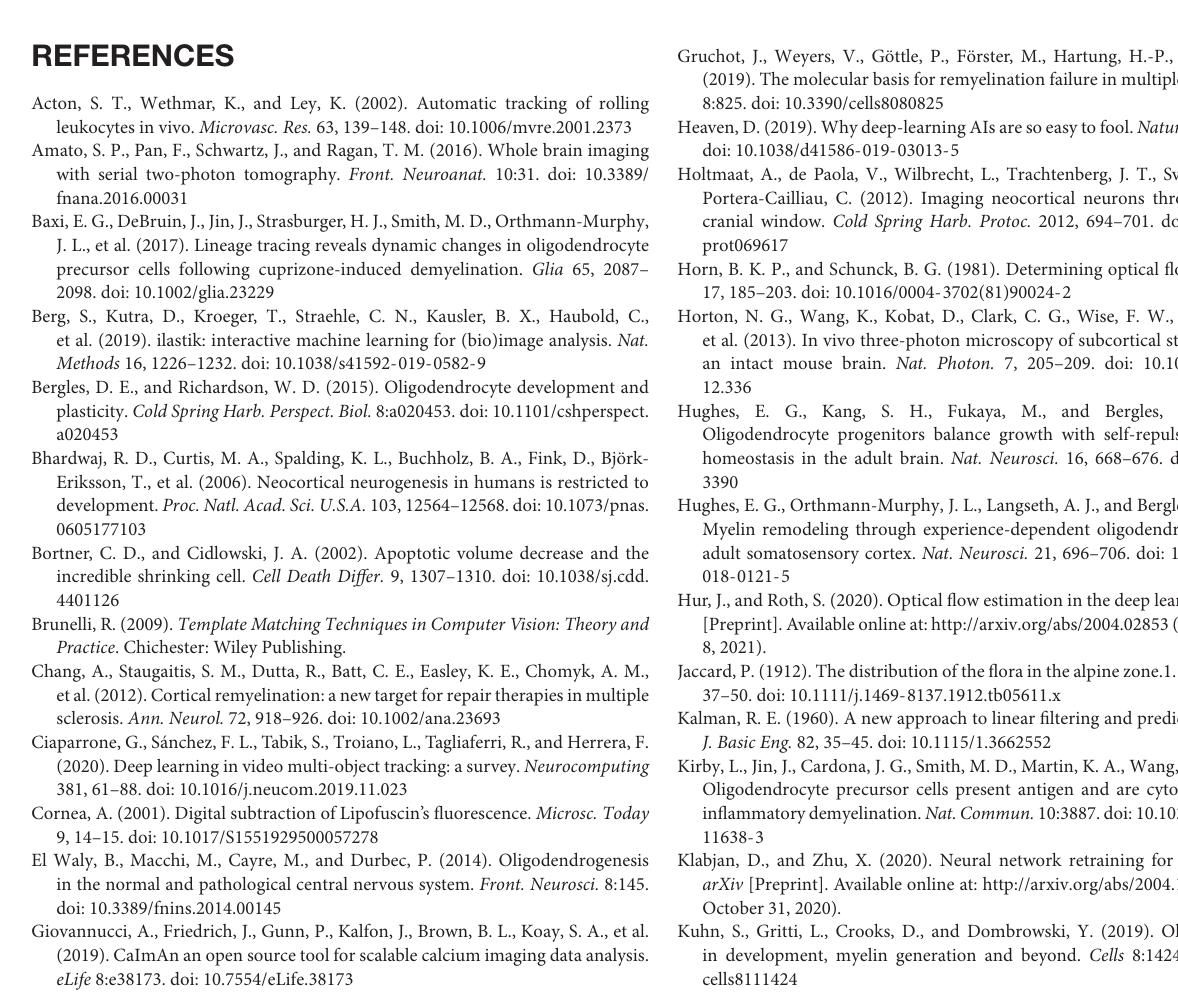
cells at low laser power. Scale bar: 25 µ m. (D) Effect of different standard deviations of random noise on Track-CNN performance. (E) Effect of changing the rotation range (in degrees) of random motion artifacts on Track-CNN performance. Scale bar: 30 µ m. Supplementary Video 1 | Cell tracking across two stable timepoints. Timepoint t (left) and t + 1 (right). Magenta indicates the cell that is currently undergoing assessment by Track-CNN. After assessment, a color is assigned to the cell on t and t + 1 to represent a tracked cell across timepoints. If the cell is untracked (or dies between timepoints), the cell soma is set to pure white on t . Supplementary Video 2 | Cell tracking across cuprizone injury timepoints. Timepoint t (left) and t + 1 (right). Magenta indicates the cell that is currently undergoing assessment by Track-CNN. After assessment, a color is assigned to the cell on t and t + 1 to represent a tracked cell across timepoints. If the cell is untracked (or dies between timepoints), the cell soma is set to pure white on t . Supplementary Video 3 | Cell sparsity over weeks of cuprizone treatment and recovery. Newly formed cells marked in green (left) and cells that will die within a week marked in red (right) starting from baseline followed by 3 weeks of cuprizone treatment and subsequent recovery. Supplementary Video 4 | Soma size of dying and newly formed cells over weeks of cuprizone treatment. Newly formed cells marked in green (left) and cells that will die within a week a marked in red (right) starting from baseline followed by 3 weeks of cuprizone treatment and subsequent